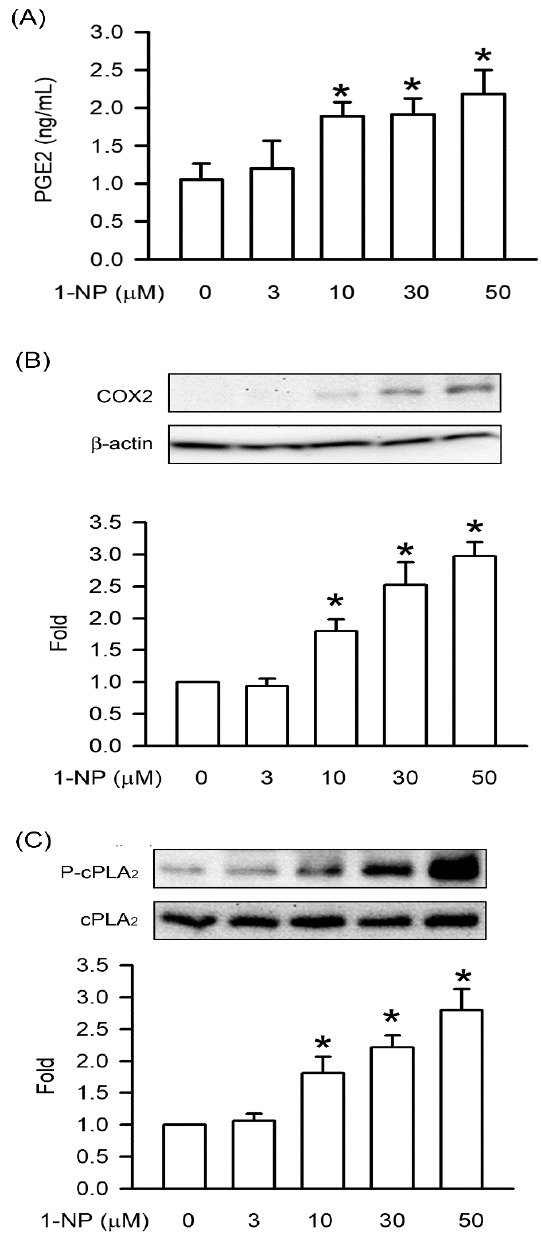
Figure 3. PGE2 production, COX2 expression, and cPLA2 phosphorylation were induced by 1-NP in RAW264.7 macrophages. ( A ) The level of PGE2 generation was measured by ELISA assay. The level of COX2 expression ( B ) and cPLA2 phosphorylation ( C ) was measured by Western blotting assay. Results are expressed as means ± SD ( n = 3). * p < 0.05 is considered significant, compared with the control group, which indicated treatment with 1-NP at 0 μ M.